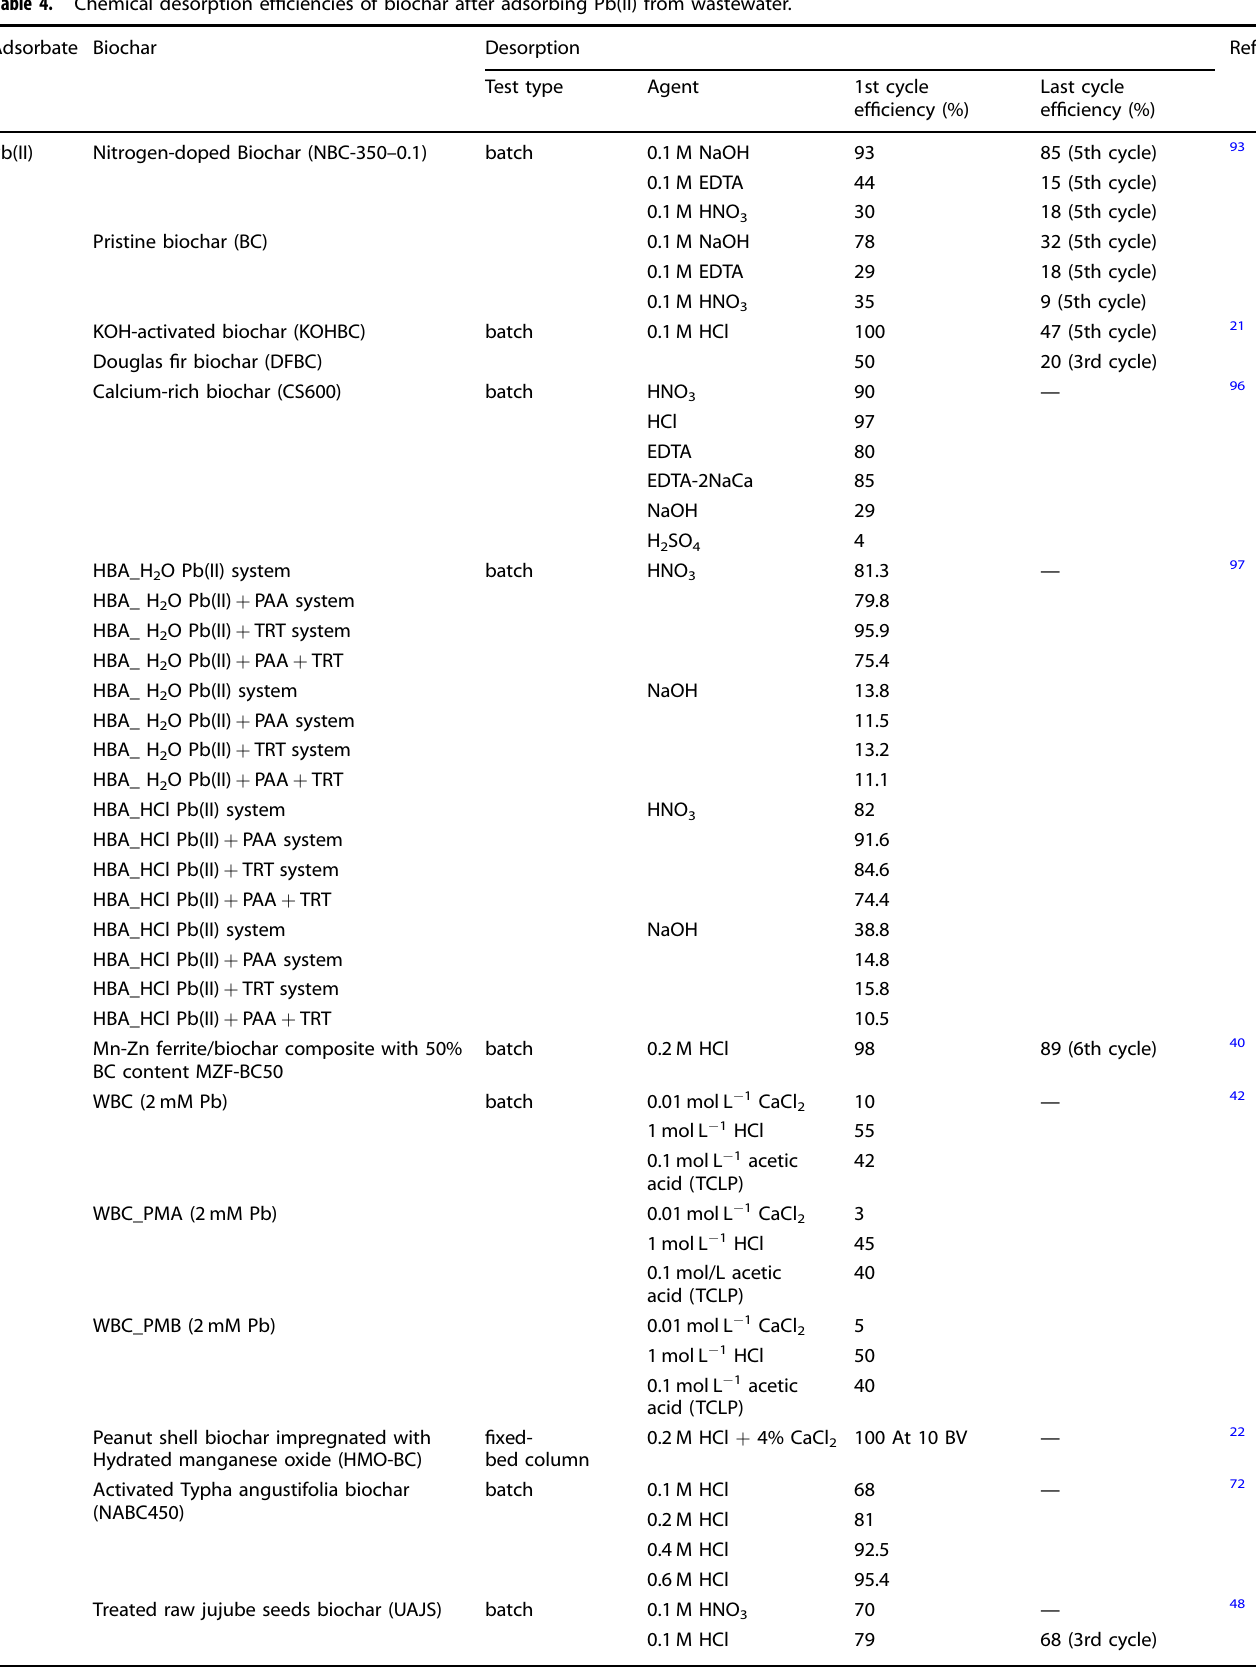
Table 4. Chemical desorption ef fi ciencies of biochar after adsorbing Pb(II) from wastewater. Adsorbate